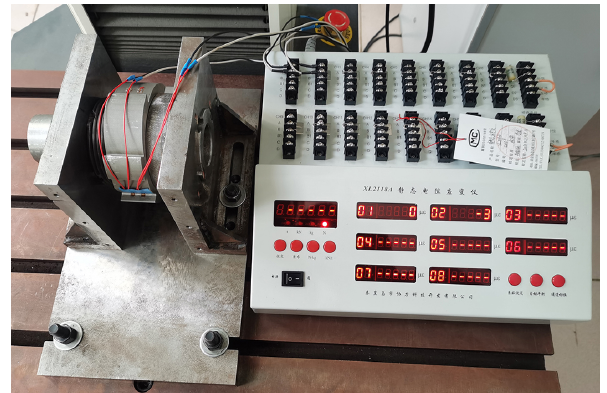
Figure 11. Strain gauge and ratchet test bed.